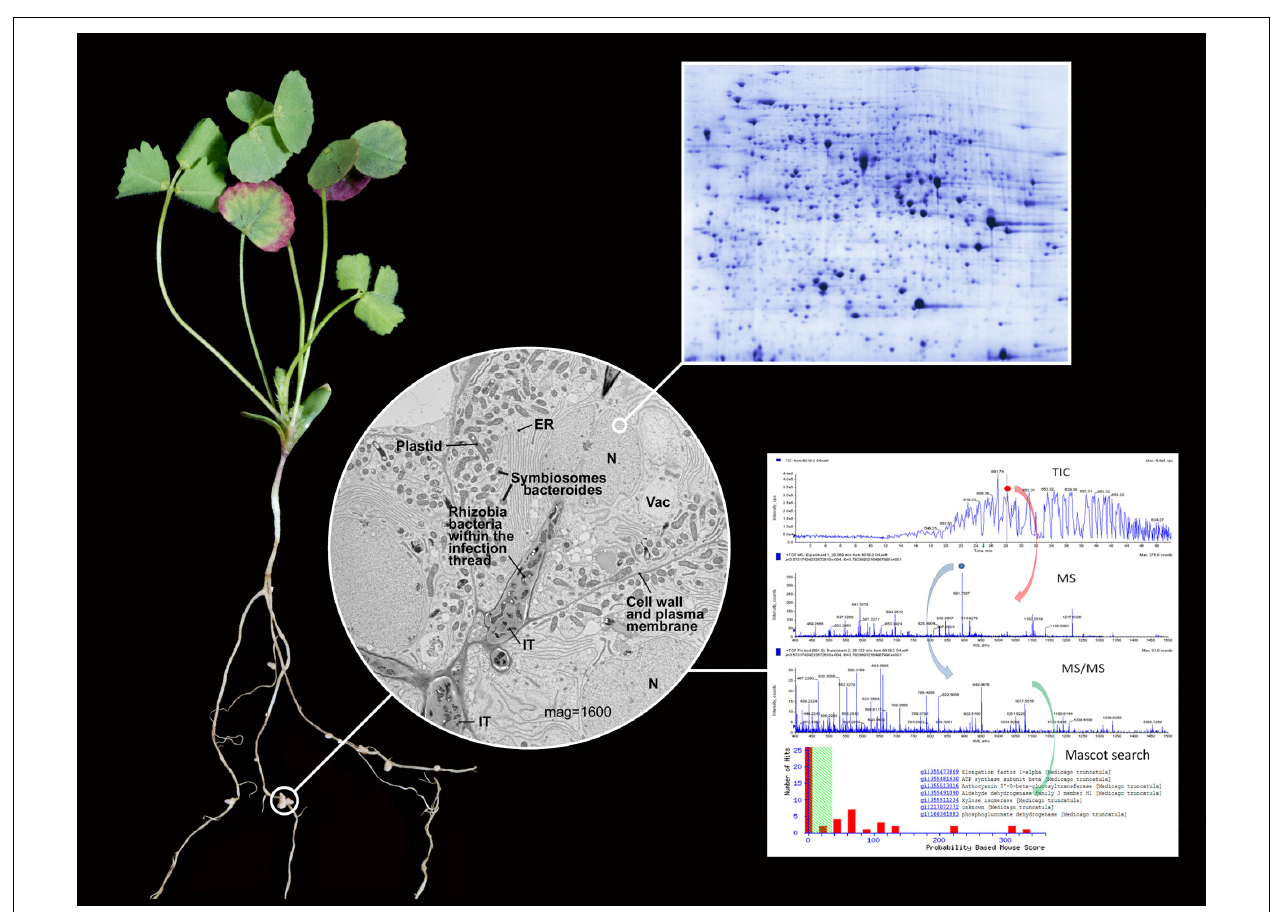
bacteria segregate from the infection thread and enter the cell and are encapsulation by a symbiosome plant membrane.The number of bacteroides generally increases with the maturity of the nodule cell. Many of the sub-cellular organelles and especially those related to symbiosis have been isolated and analyzed using various proteomics methods such as 2-DE or LC-MS/MS to better understand the protein composition and function of these specialized organelles. An example of a nano LC-MS/MS shotgun proteomics experiment is provided that includes the total ion chromatogram (TIC), full scan mass spectrum (MS), and tandem mass spectrum (MS/MS). These data are used to search predicted proteins from DNA or RNA or sequenced protein databases to identify proteins observed in the LC-MS/MS experiment.The M. truncatula micrograph was provided by Dr. Jin Nakashima, Manager of the Noble Foundation Cellular Imaging Facility, and Jiejan Xi.The plant photo was provided by Mr. Broderick Sterns.The representative 2-DE and LC-MS/MS images were provided by the